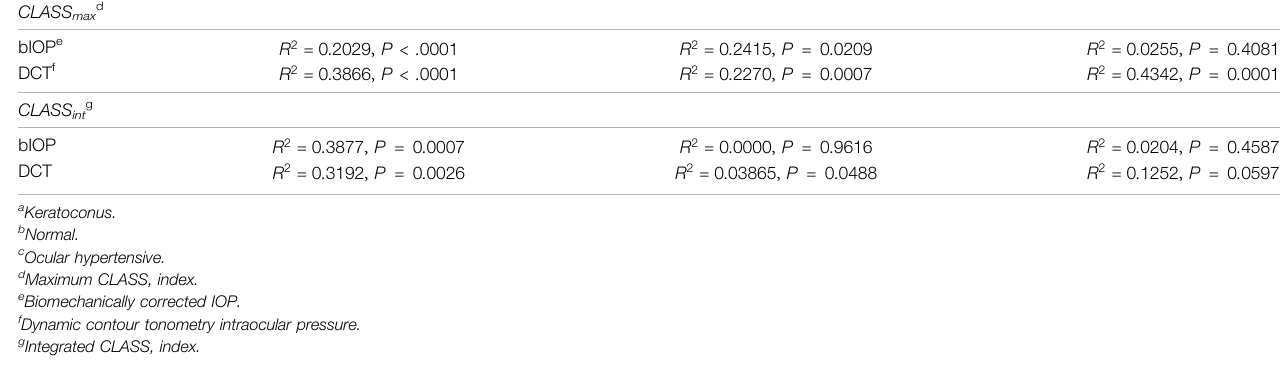
Frontiers in Bioengineering and Biotechnology |